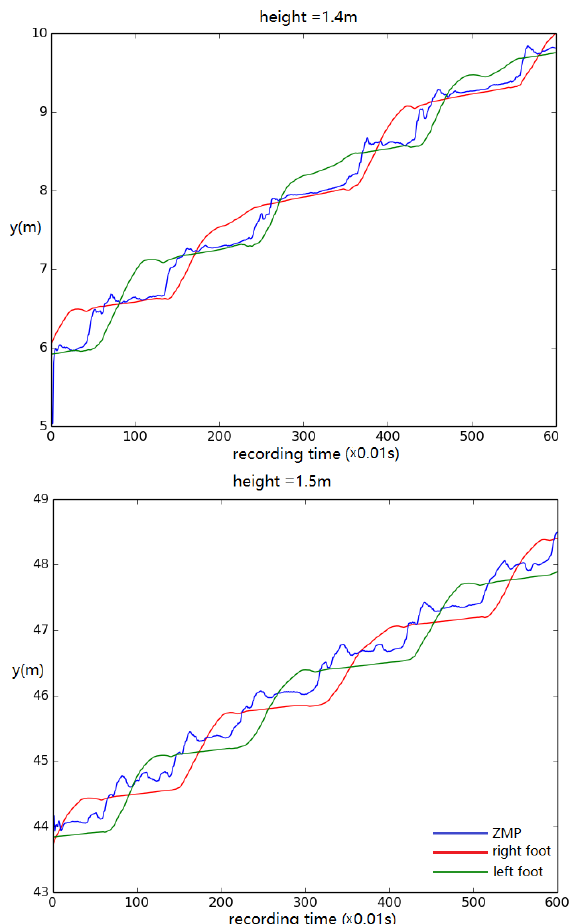
Figure 12. Foot and ZMP displacement when the body height is set to ( top ) 1.4 m and ( bottom ) 1.5 m. Displacement of torso center of mass vs. time.